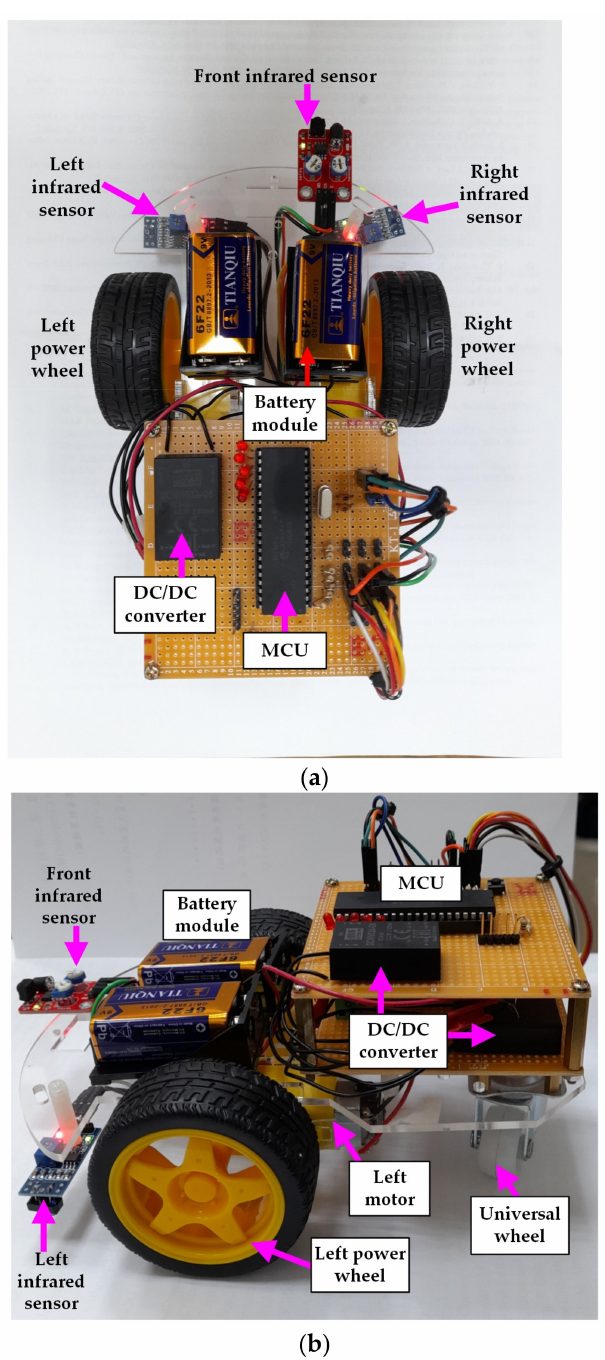
Figure 3. Arrangement of various components of the self-driving electric mobile robot: ( a ) top view and ( b ) left